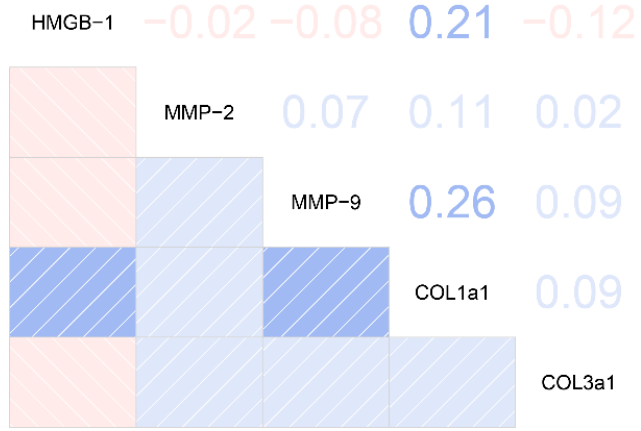
Figure 4. Correlations between plasma HMGB-1 concentrations and clinical/biological features in silicosis patients. Abbreviations: MMP-2, matrix metalloproteinase-2; MMP-9, matrix metalloproteinase-9; COL1A1, collagen alpha-1(I) protein; COL3A1, collagen alpha-1(III) protein.